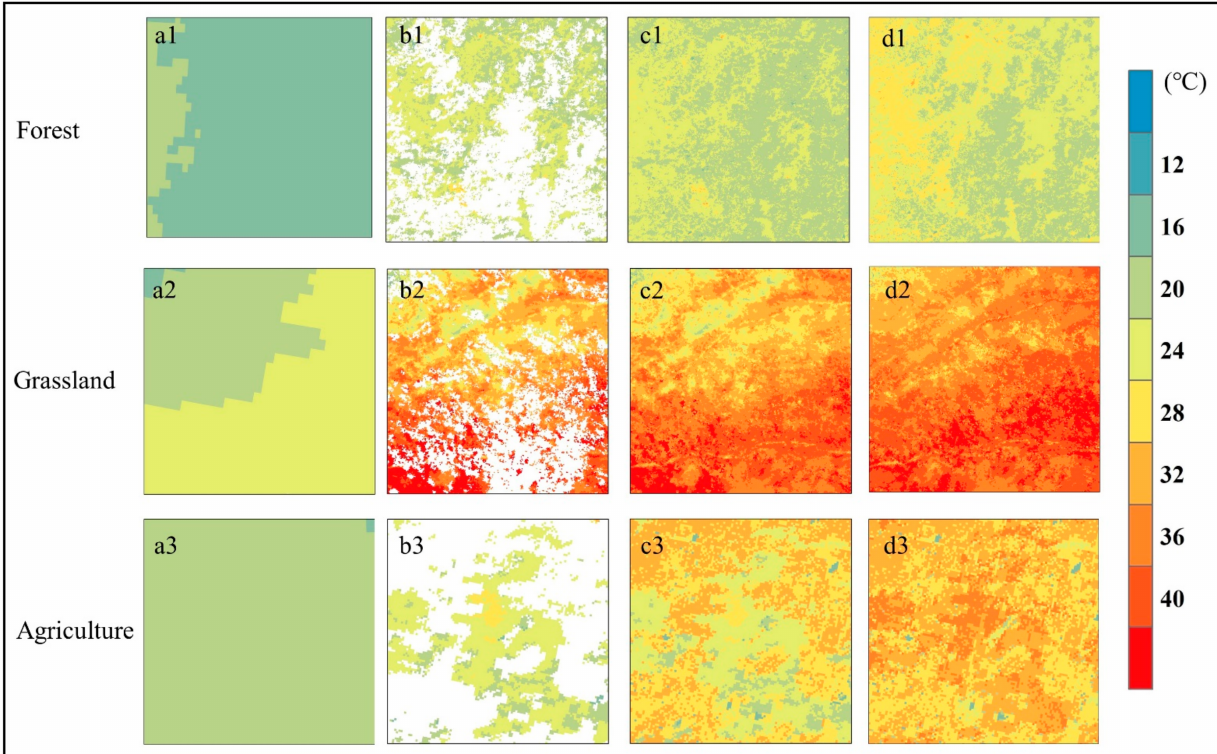
Figure 10. Example subsets of ERA5ST ( a1 – a3 ), original MODIS LST ( b1 – b3 ), gap-filled MODIS LST ( c1 – c3 ), and fully GAM-simulated LST ( d1 – d3 ) on DOY 185 (4 July